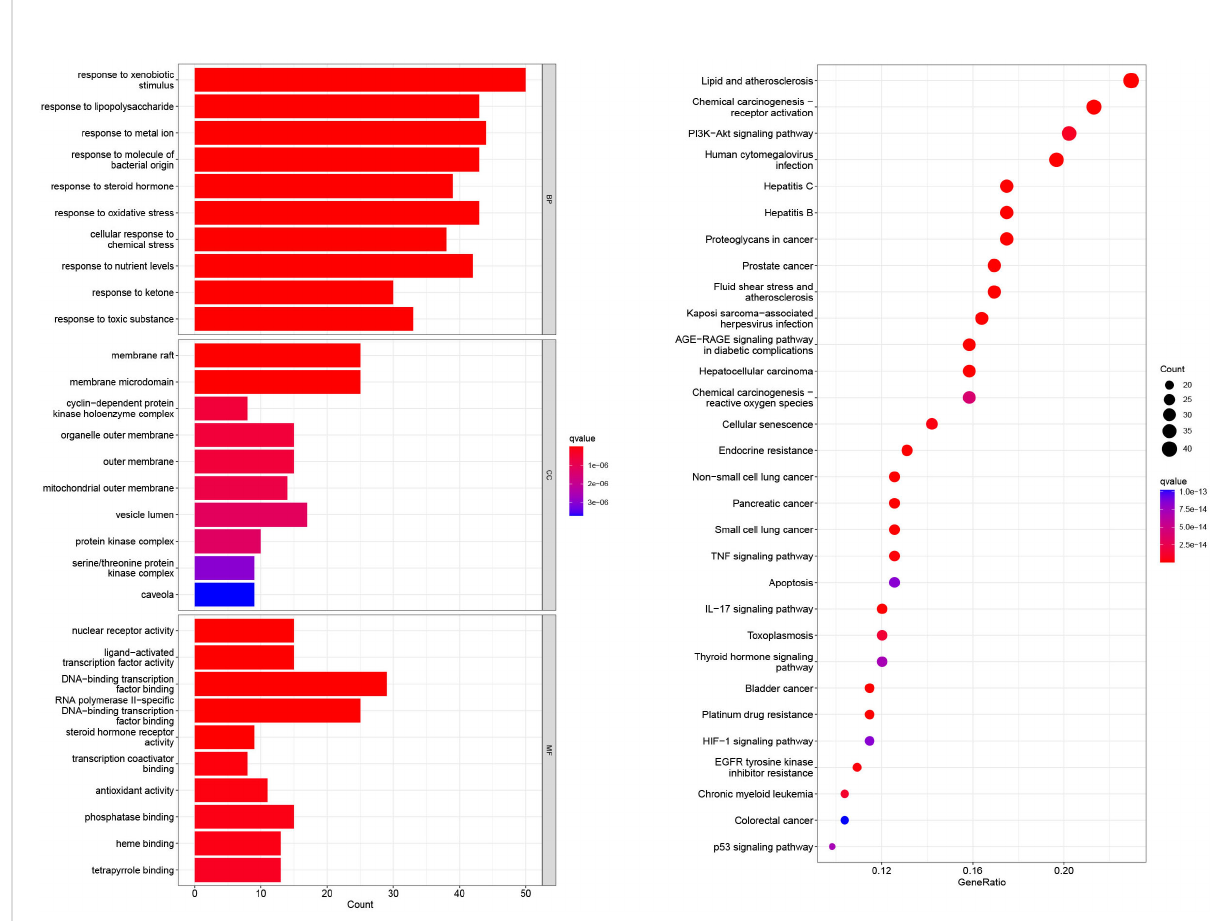
FIGURE 3 The GO enrichment analysis of core nodes. Including cellular components, molecular functions, and biological processes. The top 30 pathways for KEGG enrichment analysis of compound kushen injection.